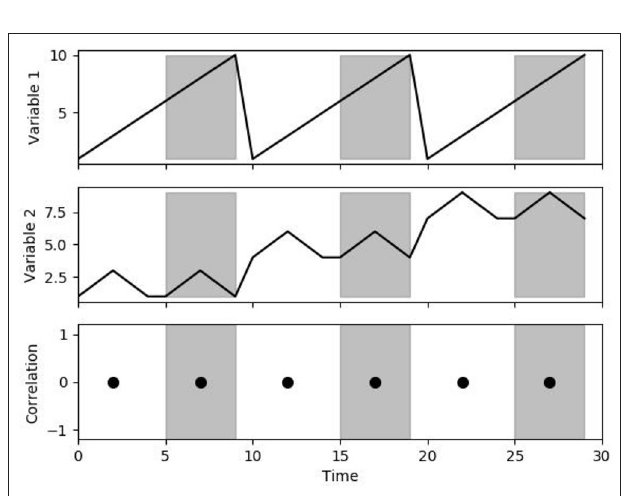
FIGURE 2 | Correlation to additive changes. The figure demonstrates the correlation between variables 1 and 2 over a 5-s time window. Note that despite the change in mean value, the correlation is still 0 (linearity is